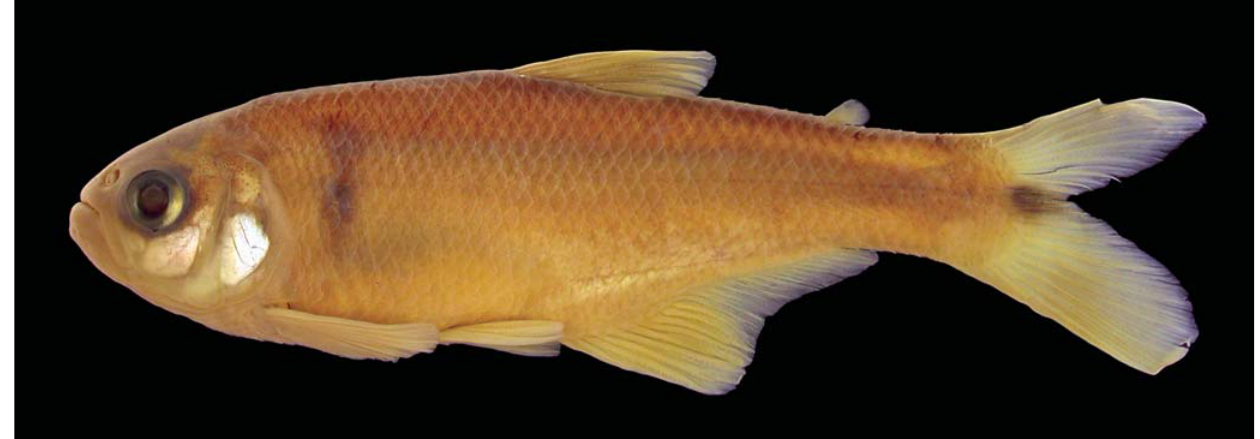
Fig. 8. Hemibrycon huambonicus , ROM 55406, male, 73.3 mm SL, upper río Ucayali basin, Peru.